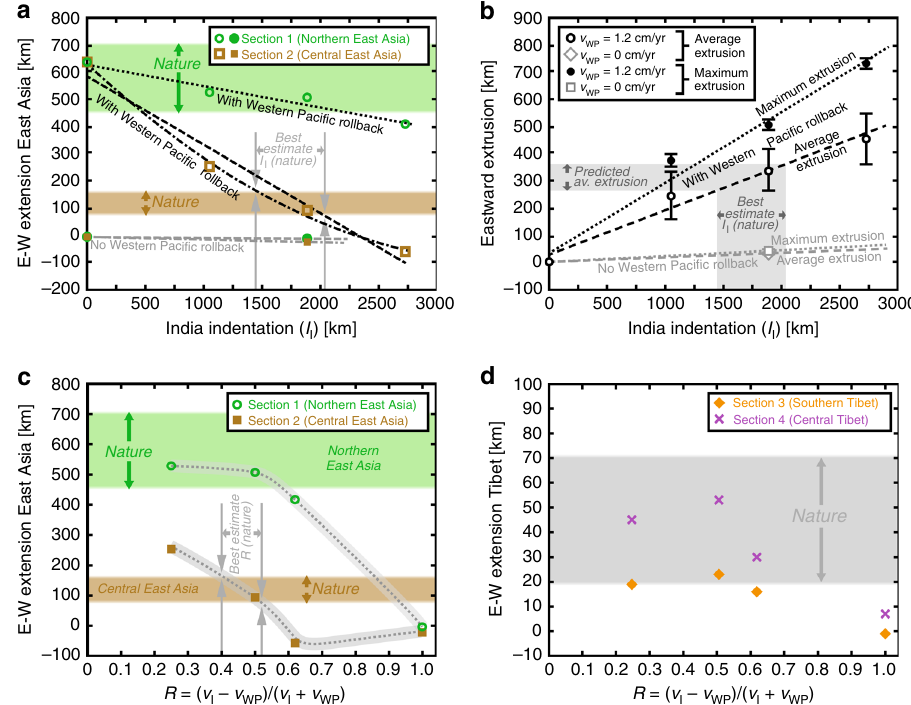
Fig. 6 Continental extension and extrusion as a function of Indian indentation ( I I ) and indenter-rollback ratio R . a East – west extension as a function of I I along two sections (1 and 2) for experiments with Western Paci fi c slab rollback (open symbols) and without Western Paci fi c slab rollback ( fi lled symbols) and for the representative sections in nature (see “ Methods ” ). b Average and maximum eastward continental extrusion as a function of I I for experiments with Western Paci fi c slab rollback (circles) and without Western Paci fi c slab rollback (diamond and square). Predicted indentation and predicted average eastward extrusion in nature are shown in a and b , respectively. Black dashed and black dotted lines in a and b are least-squares linear best- fi t lines (coef fi cients of determination of 0.964 ( a , dashed), 0.951 ( a , dotted), 0.970 ( b , dashed) and 0.980 ( b , dotted)). Correlations are statistically signi fi cant at 95% ( a , dotted, p value = 0.028), 98% ( a , dashed, p value = 0.019), 99% ( b , dotted, p value = 0.008) and 98% ( b , dashed, p value = 0.014) con fi dence level using Fisher ’ s z . Black dash-dot line in a is quadratic best- fi t line (coef fi cient of determination 0.996). c , d Finite east – west extension in East Asia and Tibet as a function of R along experimental sections 1 and 2 and sections 3 and 4, respectively, and the ranges for these sections in nature (see “ Methods ” ). For section locations in nature and experiments, see Figs. 1b and 3, respectively. Note that errors in measuring experimental values are smaller than the sizes of the individual markers. Also note that the black bars in b are not error bars but represent the minimum and maximum values measured for the average eastward extrusion and the maximum eastward extrusion as determined from the grid lines in Fig. 3 originally located north of the